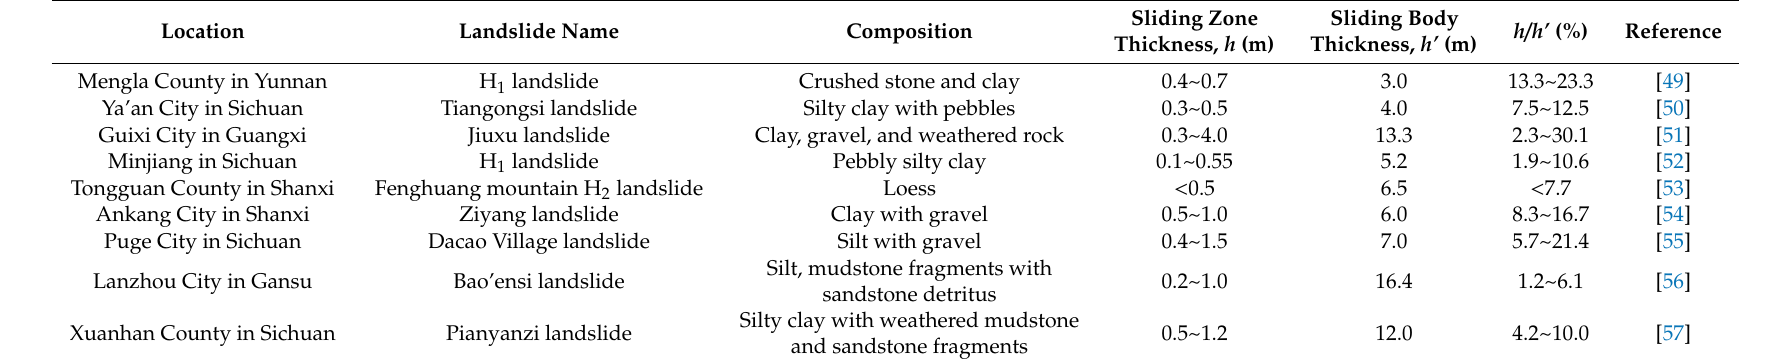
Table 1. Comparison between the sliding zone thickness and sliding body thickness in